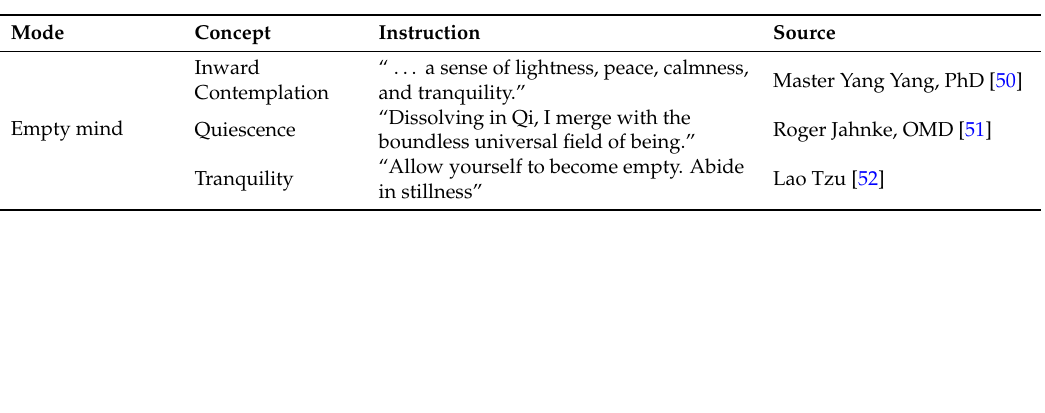
Table 1. Examples of Qigong mediation modes: empty mind vs. visualizing and directing Qi flow vs. heightened inner